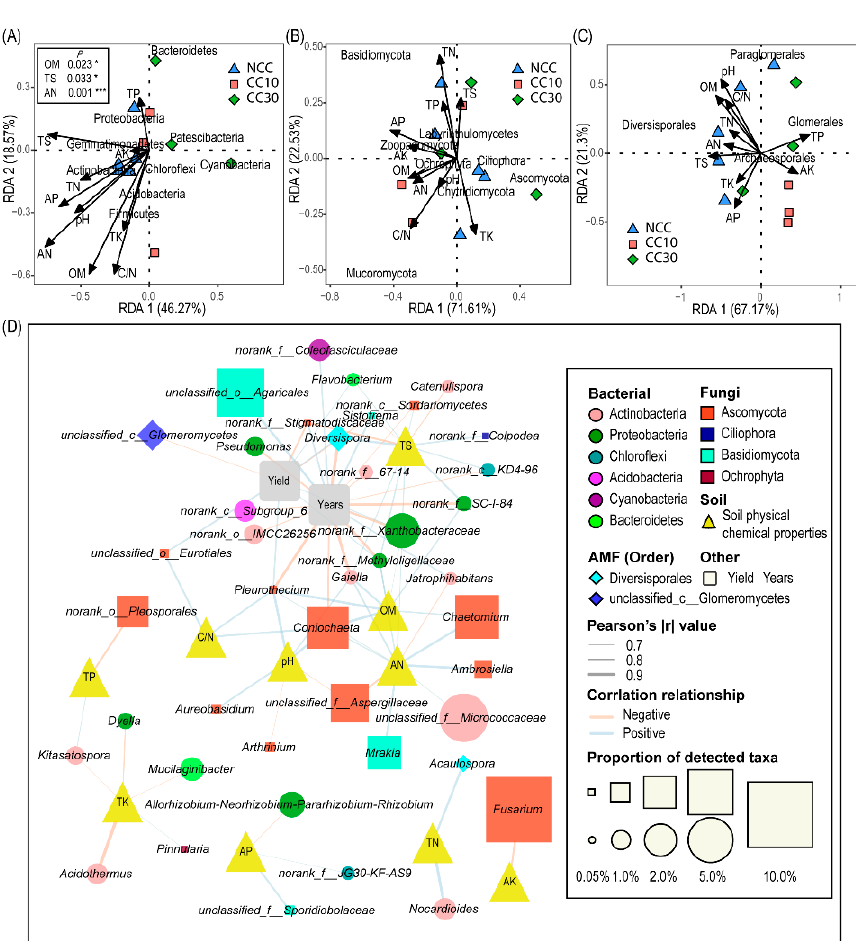
Figure 4. Redundancy analysis (RDA) identified nine selected ecological variables for shaping bacte- rial ( A ), fungal ( B ) and AM fungal ( C ) communities. Correlation analysis between microbial genus or order level and soil nutrients ( D ). TN, total nitrogen; TK, total potassium; TP, total phosphorus; TS, total sulfur; OM, organic matter; AN, available nitrogen; AK, available potassium; AP,